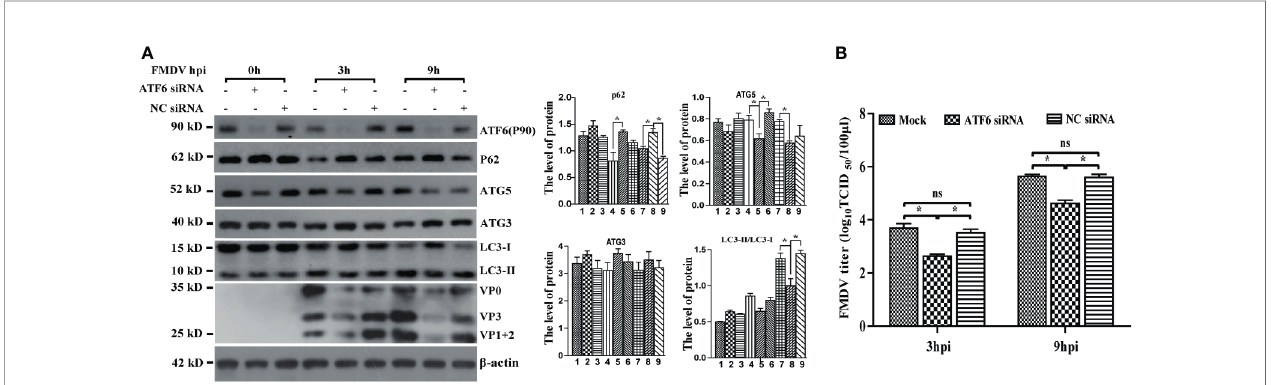
FIGURE 3 | Knockdown of ATF6 gene inhibits FMDV-induced autophagy and viral replication. (A) PK-15 cells were transfected with ATF6-speci fi c siRNA and NC siRNA against endogenous ATF6 gene, followed by FMDV infection. Total proteins were collected at directed time points and subjected to immunoblotting analysis of ATF6, P62, ATG5, ATG3, LC3, FMDV structure proteins, and b -actin. The levels of related proteins were normalized to b -actin; data were expressed as means ± SD of three experiments. Every treatment group compared with control groups, respectively; * p < 0.05, ns, no signi fi cance. (B) The viral titers were determined by TCID 50 in ATF6-knocked down cells.